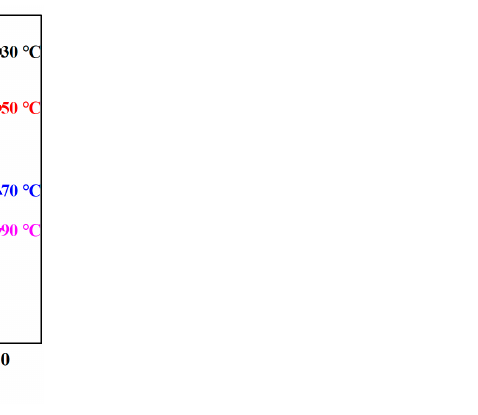
Figure 2. DCP content dependence of DC breakdown strength for samples at 30, 50, 70 and 90 °C.